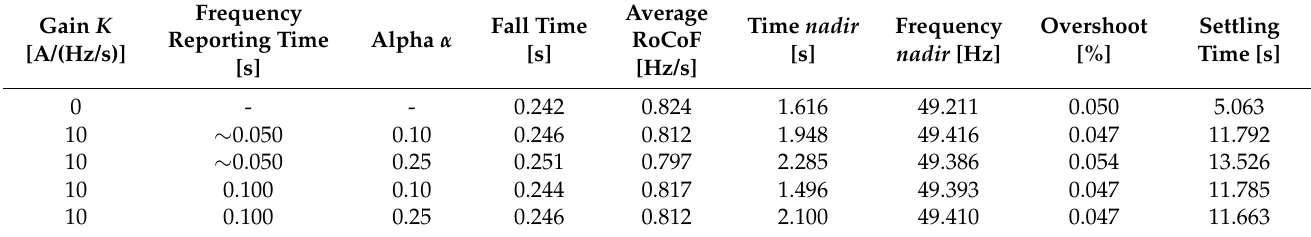
Table 4. Real synthetic inertia controller: comparison of frequency step response with different reporting